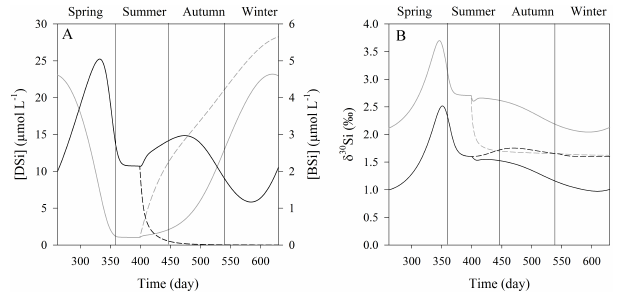
Fig. 13. Model run with no post-bloom BSi production. (A) DSi and BSi concentrations and (B) the δ 30 Si of DSi and BSi. BSi is black, DSi is grey. The solid line represents the initial run and dotted lines represent the run where BSi production is halted at the end of net nutrient